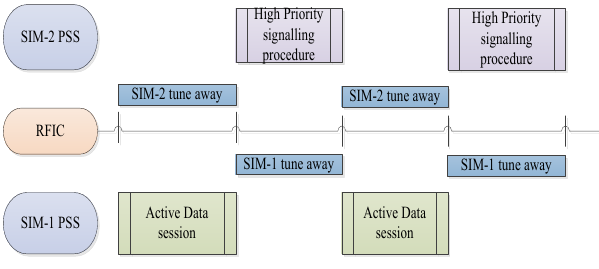
Figure 1 . DSDS Operation in SIM-1 and SIM-2 rapidly used by consumers leveraging the benefit of multiple Networks/ Radio Access Techniques/ Mobile numbers /Data Tariff plans with the same UE (currently DSDS UEs occupy 74% market share in China and